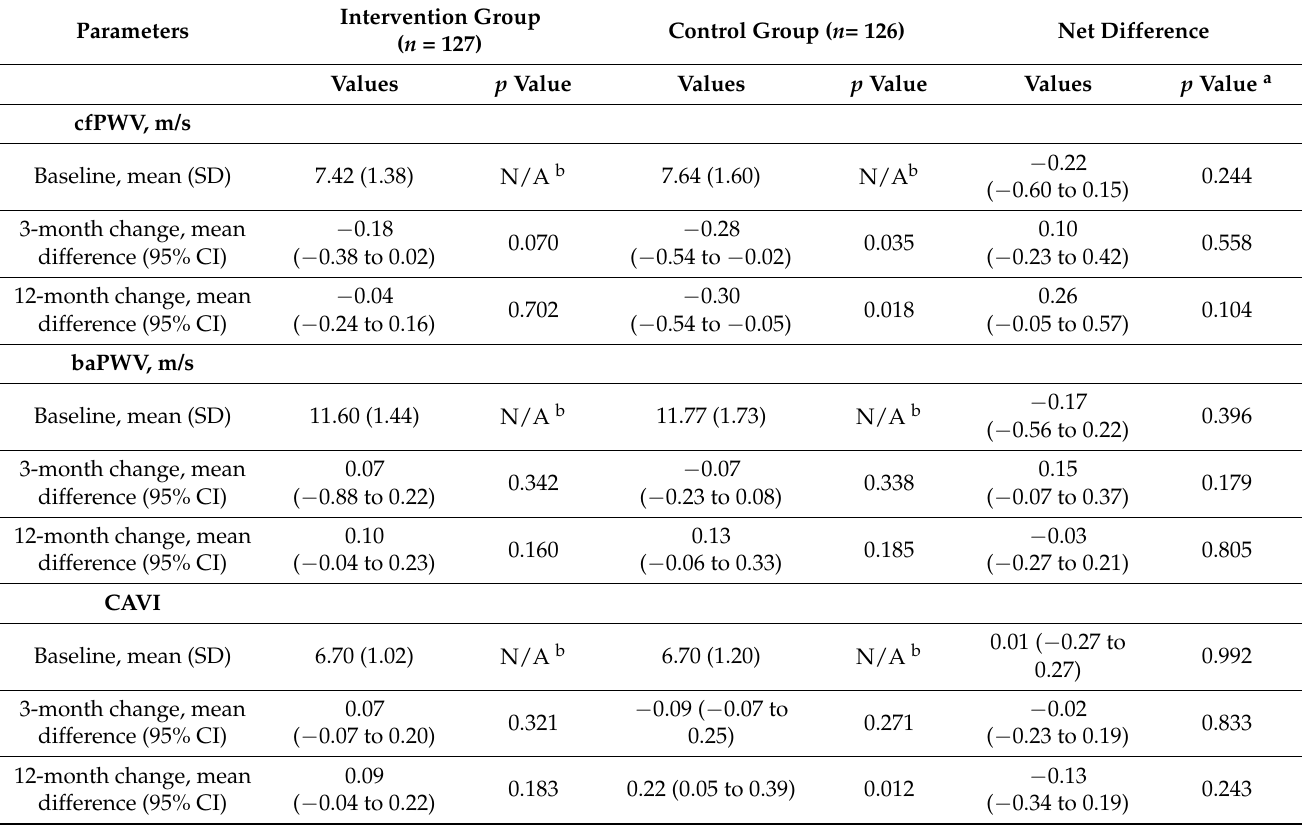
Table 2. Effect of the mobile health intervention on arterial stiffness.